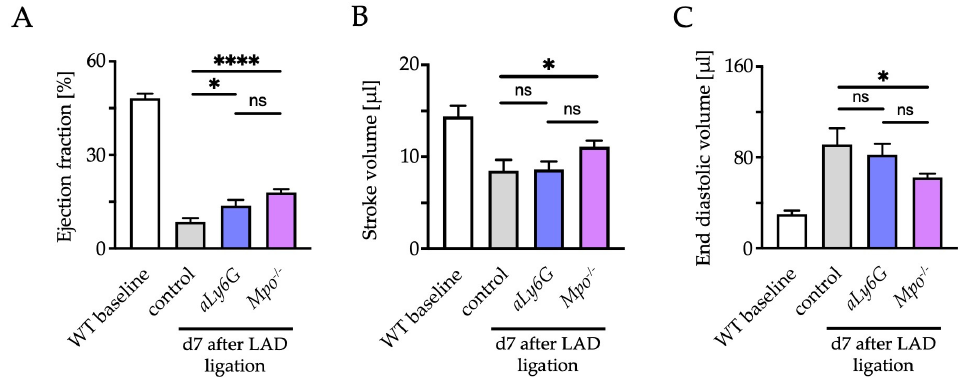
Figure 2. Echocardiographic assessment of ( A ) left ventricular (LV) ejection fraction, ( B ) LV stroke volume and ( C ) LV end diastolic volume 7 days after PI. n = 4/10/8/11; * p < 0.05, **** p < 0.0001, ns = not significant; one way ANOVA test followed by appropriate post hoc test, mean ± SEM is